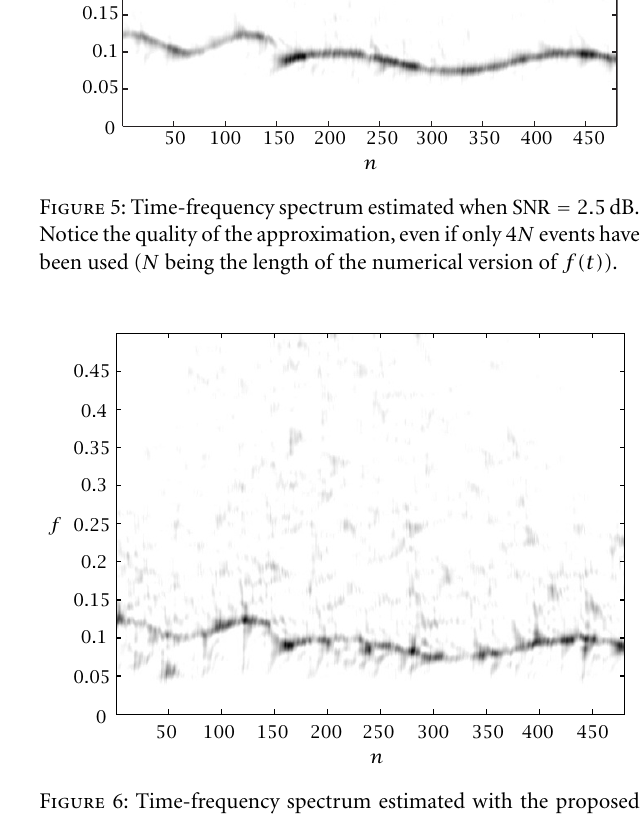
Figure 6: Time-frequency spectrum estimated with the proposed method when SNR = − 7 dB. The number of events is 40 N , to guar- antee a sufficient estimation of the original